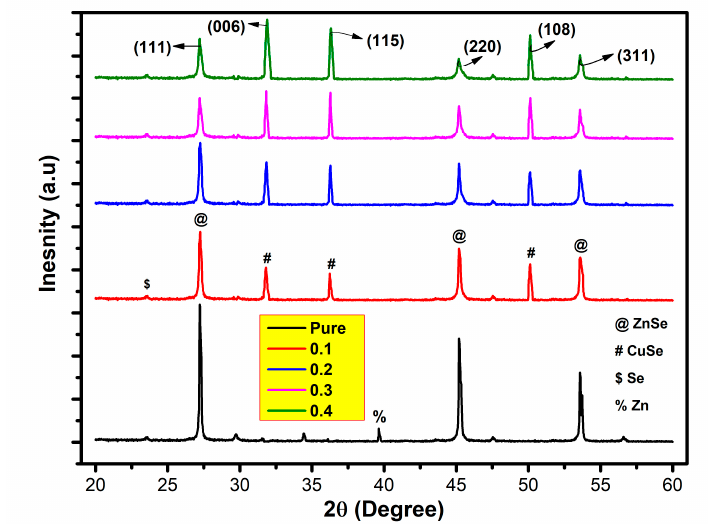
Figure 4. XRD patterns of undoped and Fe-doped ZnSe nanoparticles, synthetized using the hydrothermal method.